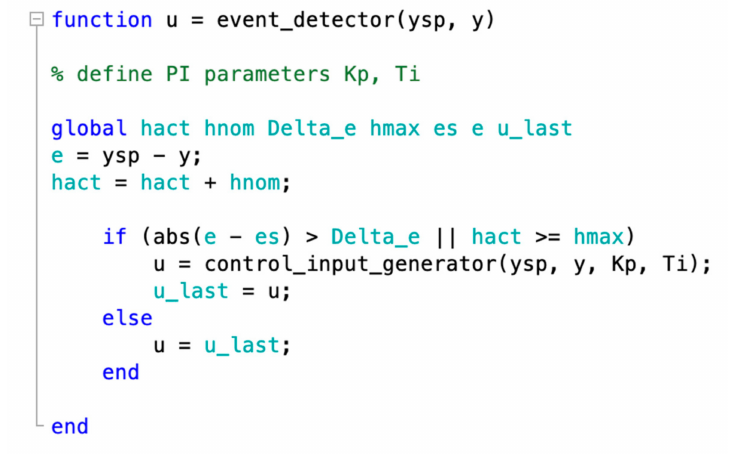
Figure 4. Event detector function.